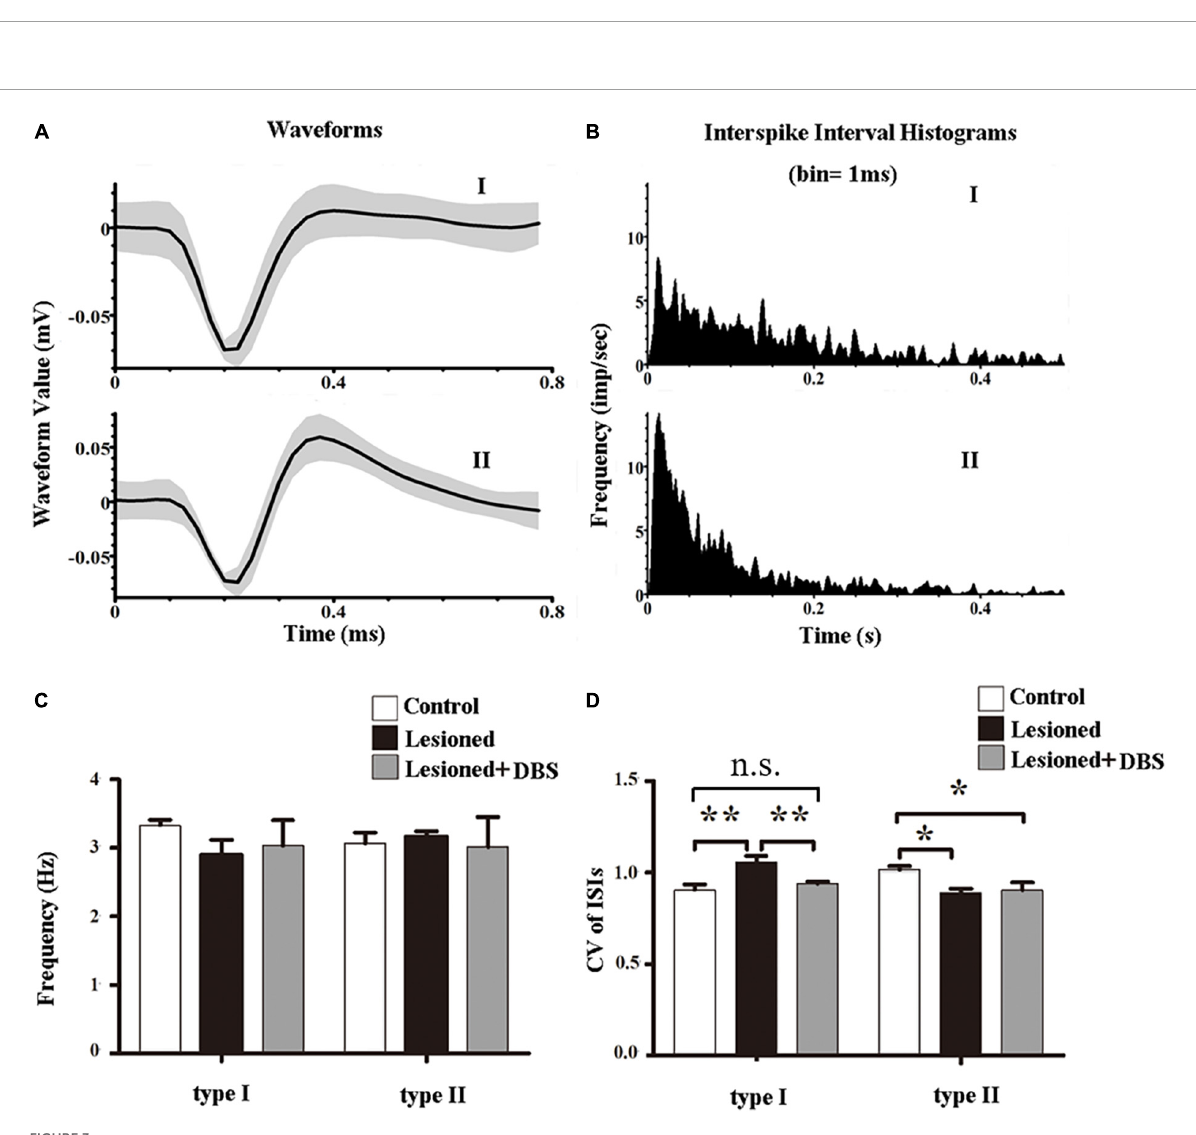
FIGURE3 Effects of GP-DBS on the spike activity of PF. (A) Examples of waveforms of type I and type II neurons. Black lines represent averaged waveforms. (B) ISI histograms of type I and type II neurons. (C) Firing rates of the two types of neurons in the PF. (D) CVs of the ISIs for the two types of neurons in the PF. * p < 0.05, ** p <